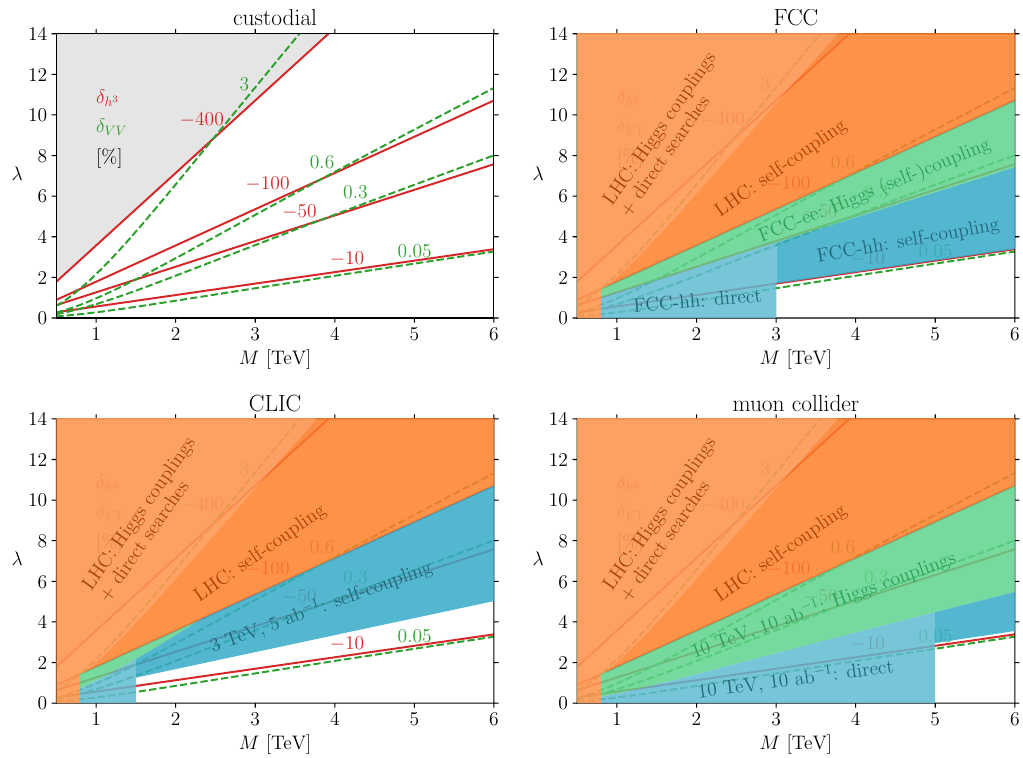
Figure 3 . Parameter space of the custodial quadruplet model. Top left: single-Higgs coupling and self-coupling deviations. In the grey region, vacuum stability requires sizeable contributions from potential terms not included in our analysis. They would affect both δ modifications by order-one factors, although their ratio may be relatively stable. Top right: regions probed, at the two-sigma level, by different types of future measurements at the LHC and FCC. Some prospects are only qualitatively estimated rather than robustly established. Bottom left: same, but assuming a 3 TeV lepton collider as future project. Bottom right: same, but assuming a 10 TeV muon collider as future